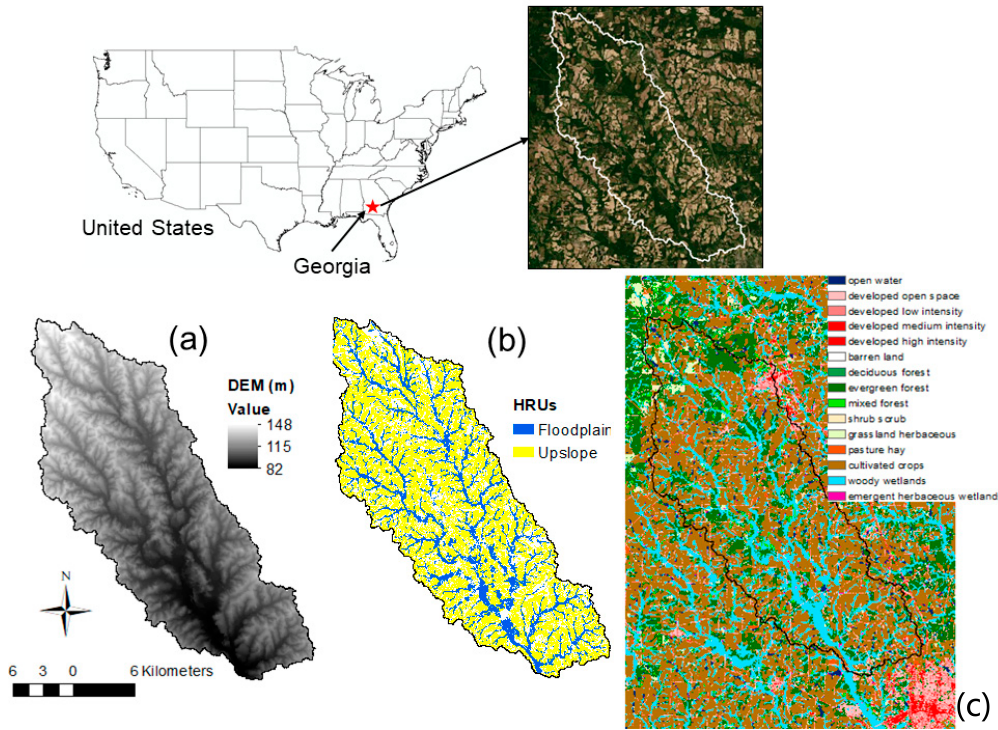
Figure 4. Geographic location and SWAT+ datasets and computational units, showing ( a ) digital elevation model (DEM) (m); ( b ) Hydrologic Response Units (HRUs), showing HRUs located in the upland areas and the floodplain areas; and ( c ) land use.